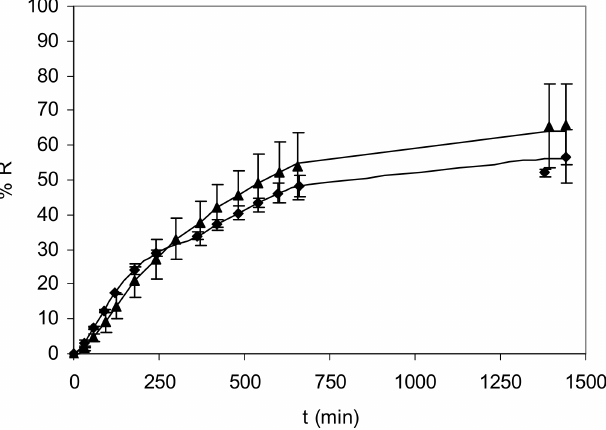
Figure 4. Temporal variation of recovery efficiency for a synthetic (35 g · L − 1 NaCl) ( ) and a real seawater sample ( (cid:78)